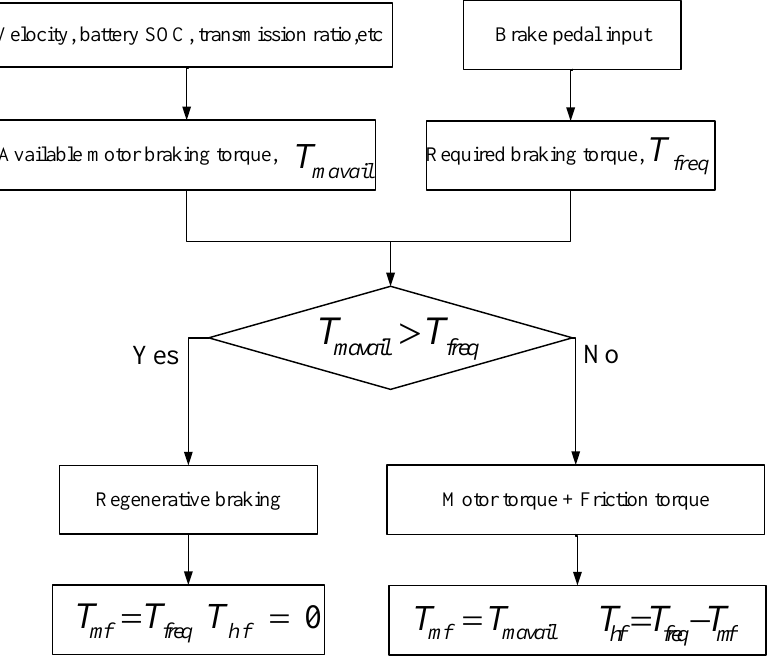
Figure 7. Flow diagram of regenerative braking. SOC : state of